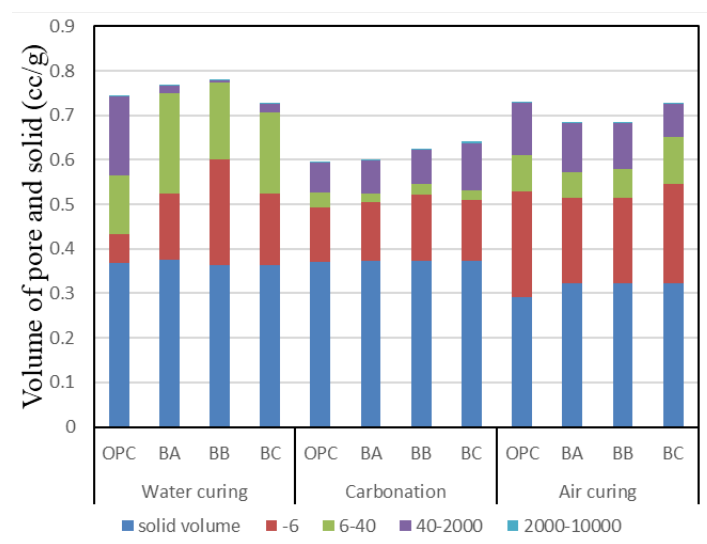
Figure 11. Pore structure of carbonated cement paste.